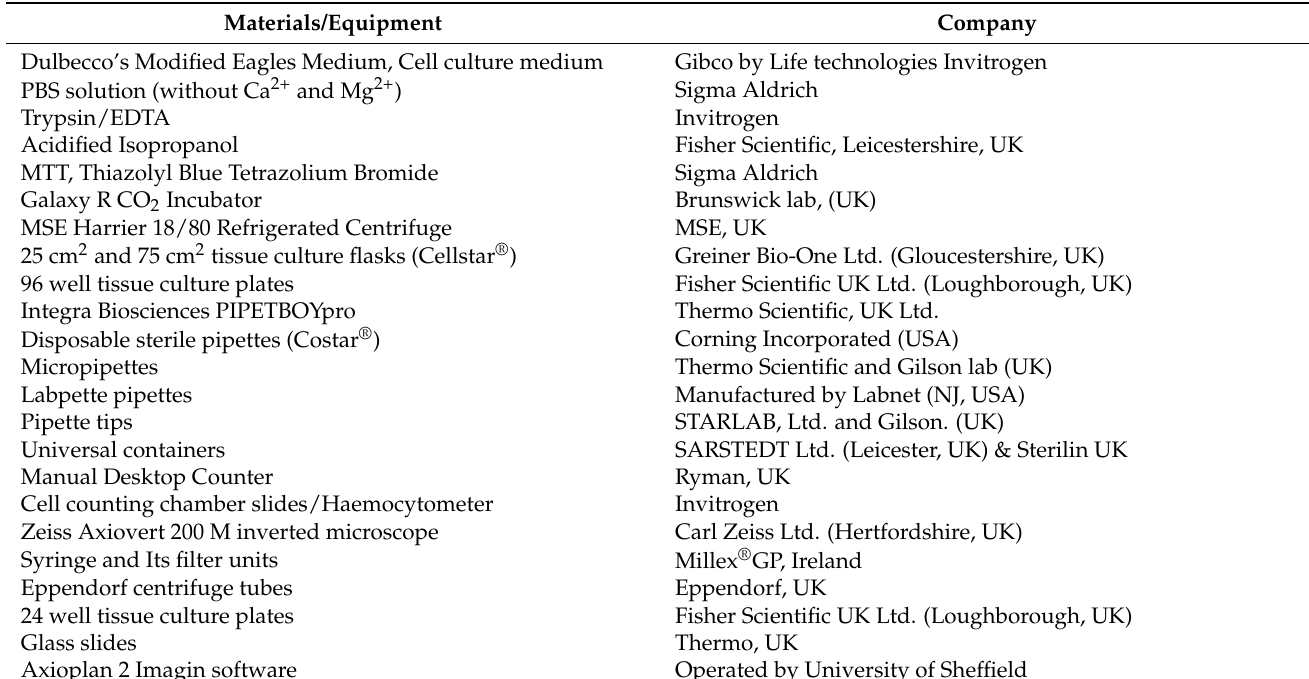
Table A1. Materials and equipment used in the